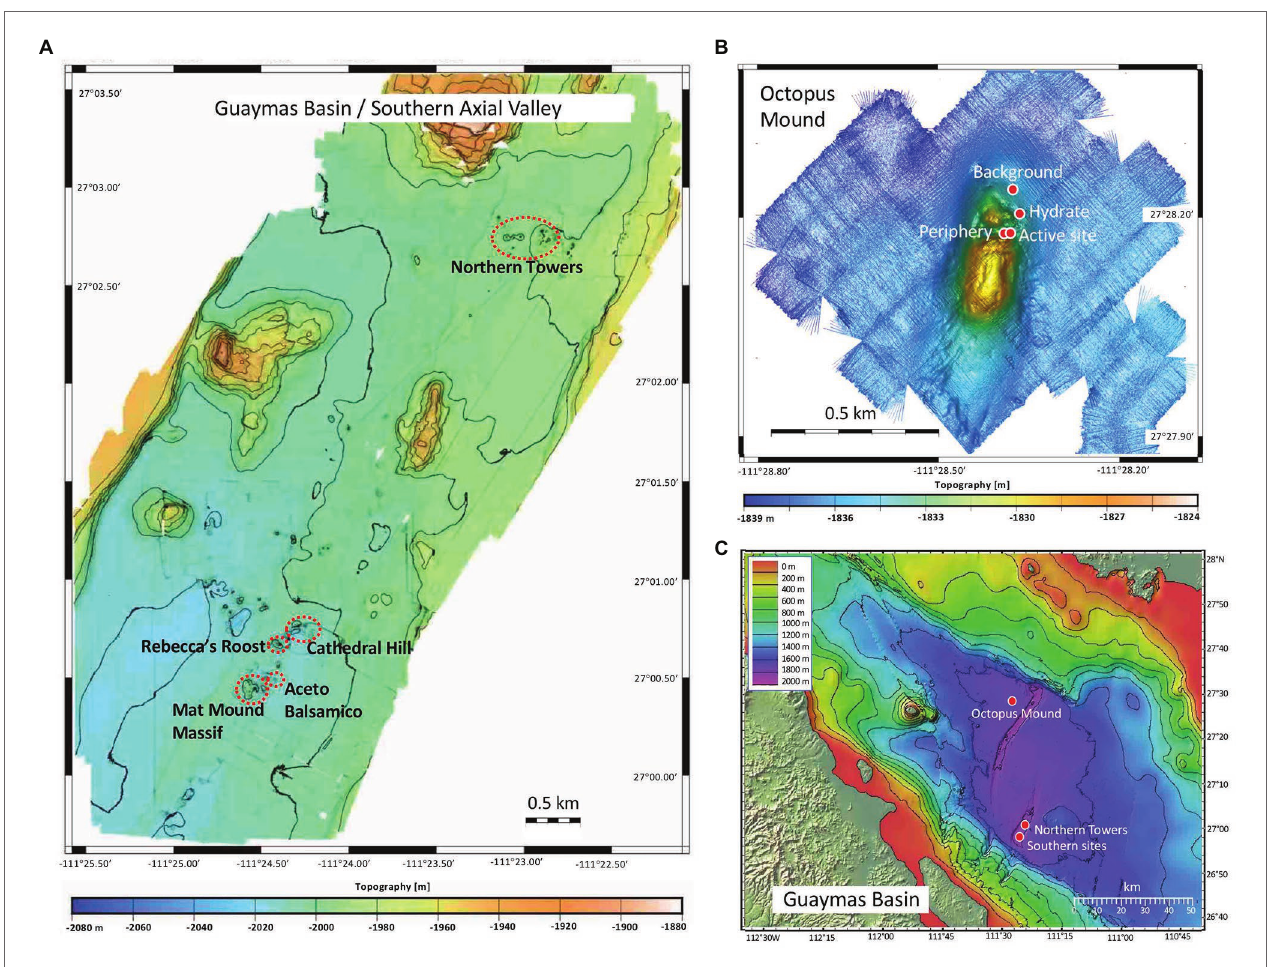
FIGURE 1 | Bathymetric maps of Guaymas Basin and Expedition AT37-06 sampling locations. (A) Guaymas Basin southern axial valley, mapped during Sentry dives 407-409 and 413-417. (B) Central Seep area with Octopus Mound, mapped during Sentry dive 412. (C) Guaymas Basin overview annotated with sampling sites, based on a template courtesy of C. Mortera,